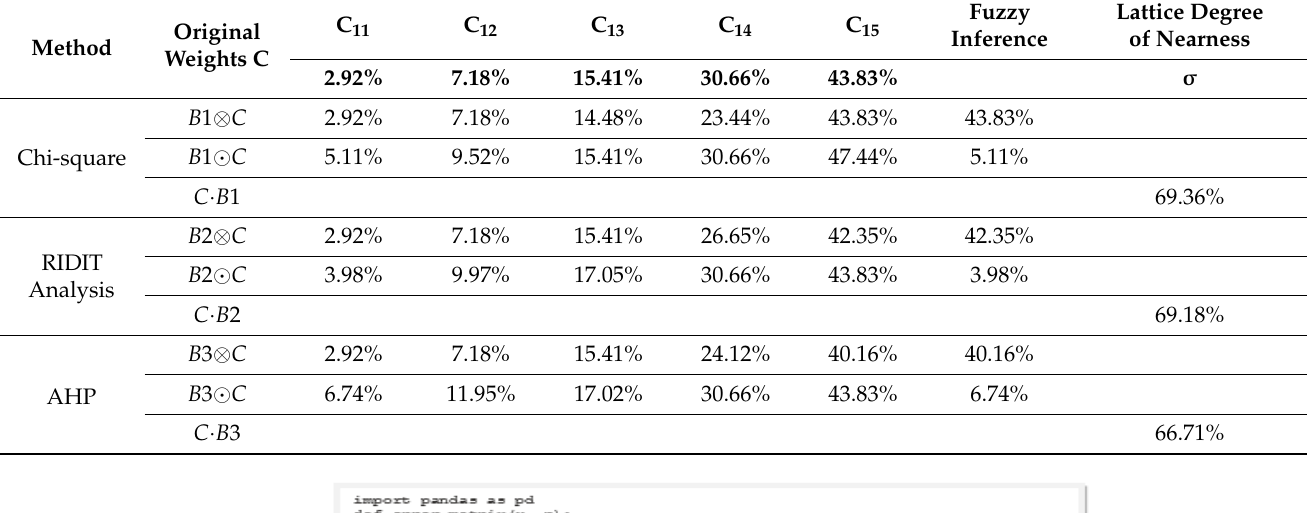
Table 8. Lattice Degree on Nearness.